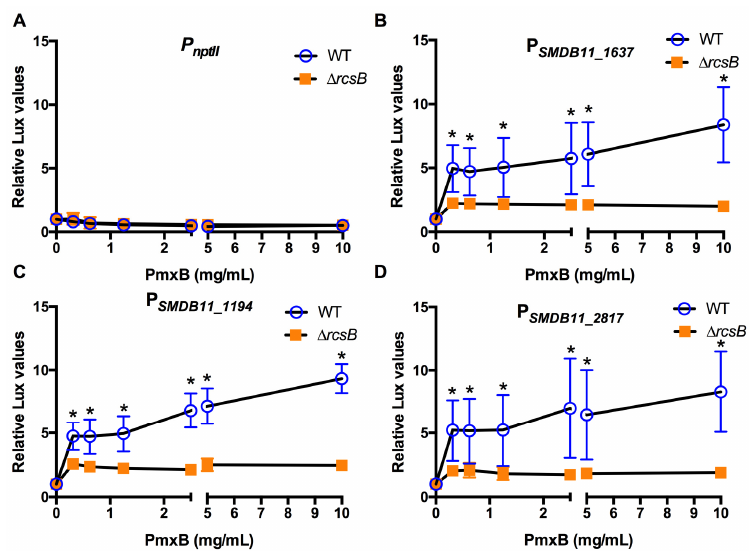
Figure 3. Effect of cell envelope-targeting antibiotic polymyxin B on Rcs-activated promoters ( A – D ). Relative luminescence values were determined by dividing luminescence by optical density after 4 h of antibiotic challenge. The nptII promoter ( A ) was unaffected by polymyxin B; however, the Rcs-dependent promoters ( B – D ) were activated to a greater extent in the WT than the Rcs-defective ∆ rcsB mutant. Mean and standard deviation are shown ( n = 6–9 are shown). Asterisks (*) indicate statistical differences between groups at the indicated concentrations, p < 0.05. Antibiotics 2021 , 10 , x FOR PEER REVIEW